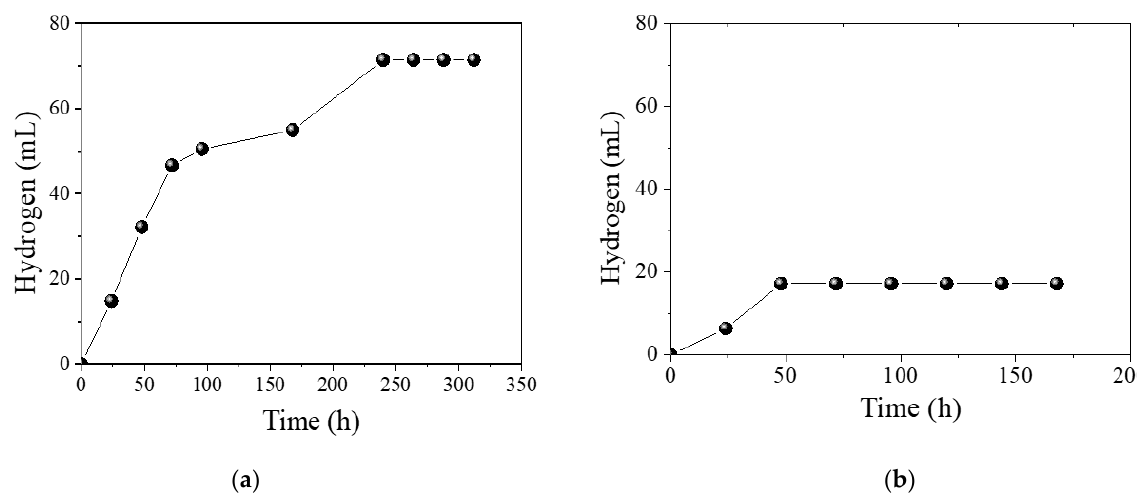
Figure 3. Cumulative hydrogen production in the cathode of ( a ) MEC1 and ( b ) MEC2, for an acetate-based synthetic wastewater feed. Applied cell potential: 0.9 V.